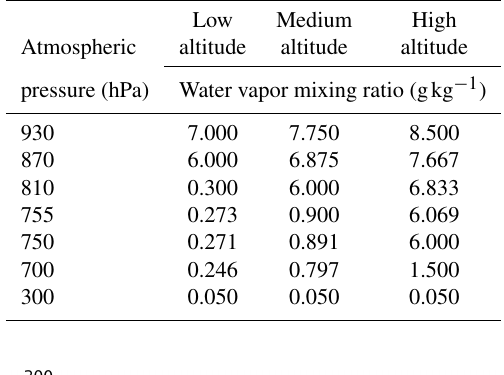
Table 1. Synthetic atmospheric humidity profiles shown in Fig. 2.